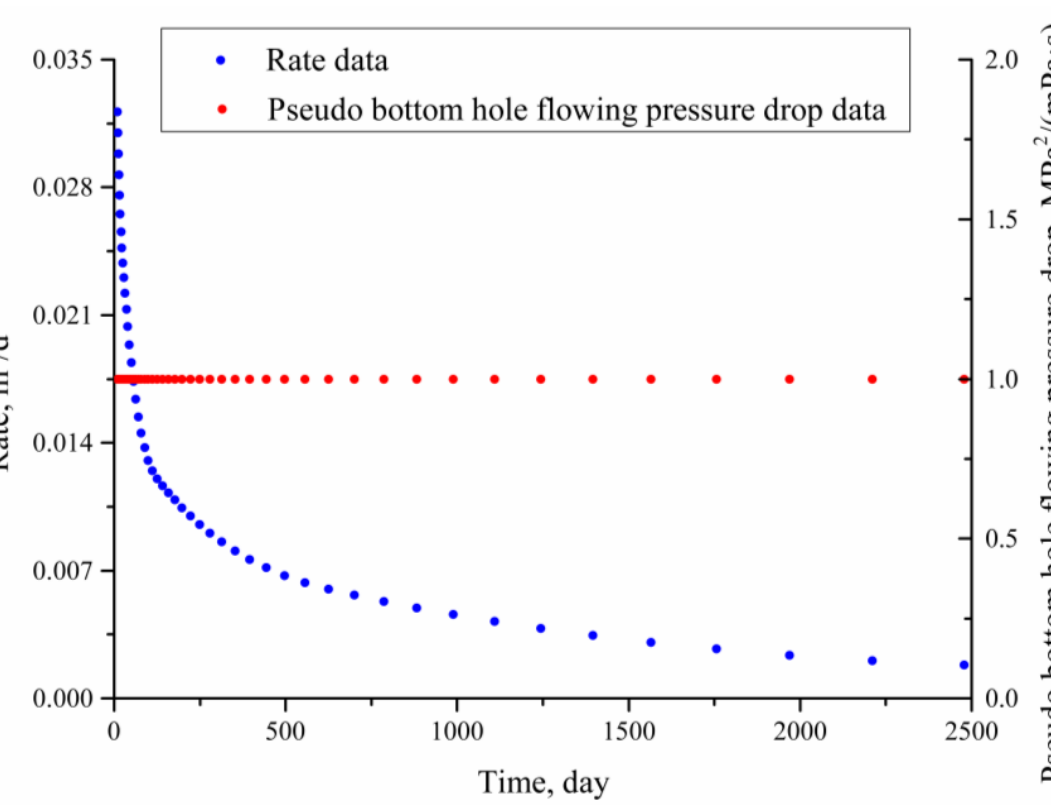
Figure 9. Flow rate data per unit pseudo bottom hole flowing pressure drop.